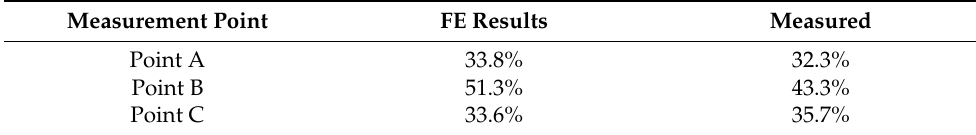
Table 5. Differences between FE results and measured demagnetization values.